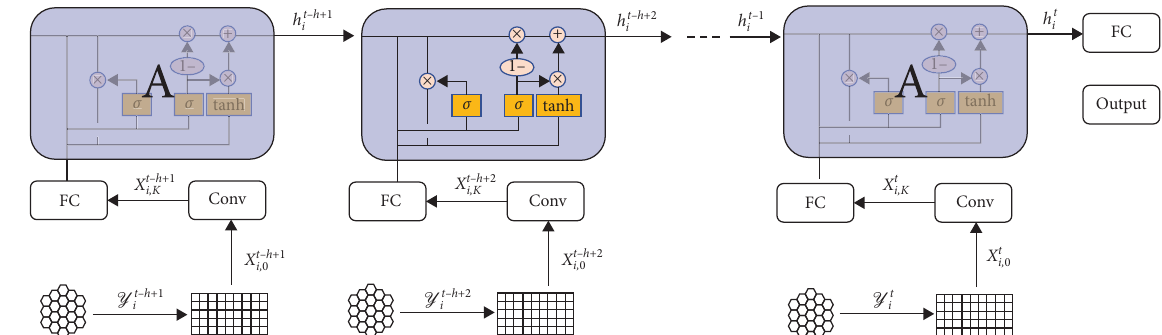
Figure 3: The architecture of the H-CNN-GRU.